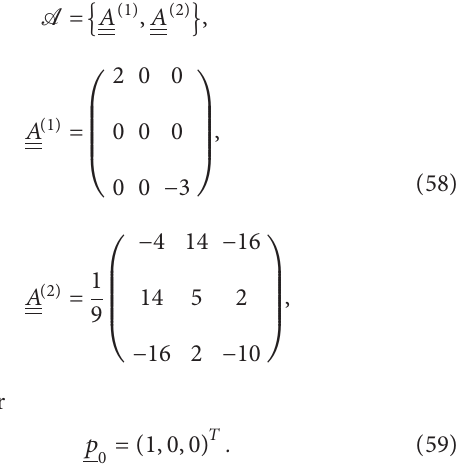
Figure 3: (a) Parameter region B x for the marked black points of